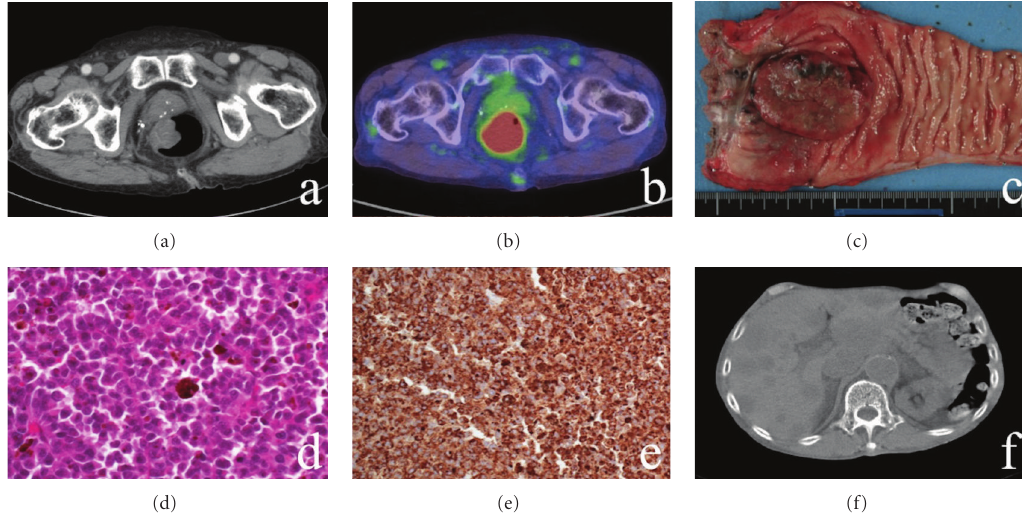
Figure 1: Case 1 CT, FDG-PET, MRI, and pathological imaging. (a) CT shows that the tumor into the lumen. (b) FDG-PET shows that increased accumulation of FDG. (c) Macroscopic image of the rectal tumor showing pigmented lesions. (d) Histopathological examination of the rectal specimen showed the nest of melanocytic cells (e.g., HE stain, × 40). (e) Rectal specimen is positive for the expression of HMB-45 ( × 20). (f) CT shows multiple liver